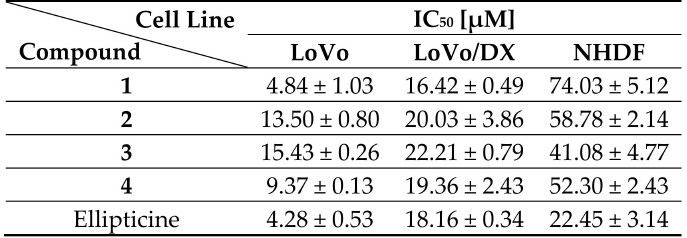
Table 1. Results of MTT assay — IC 50 values for tested compounds in various cell lines.